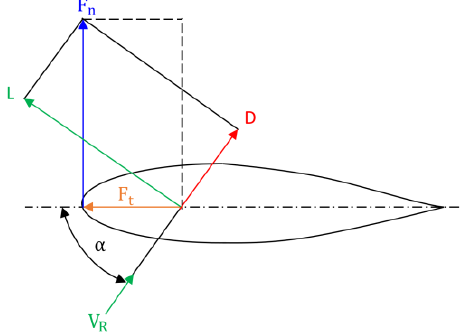
Figure 5. Force diagram of a blade airfoil.